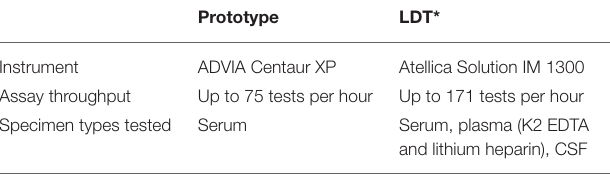
TABLE 1 | Summary of the neurofilament light chain (NfL) prototype and laboratory-developed test (LDT) assays’ key